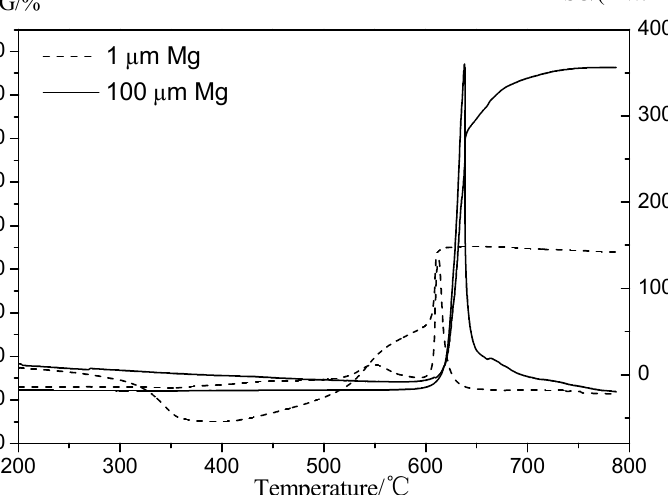
Figure 13. Differential scanning calorimetry/thermogravimetry (DSC/TG) results of small (dotted lines) and large (continuous lines) Magnesium particles showing dependence on particle size. The curves with sharp peaks are the DSC analyses.